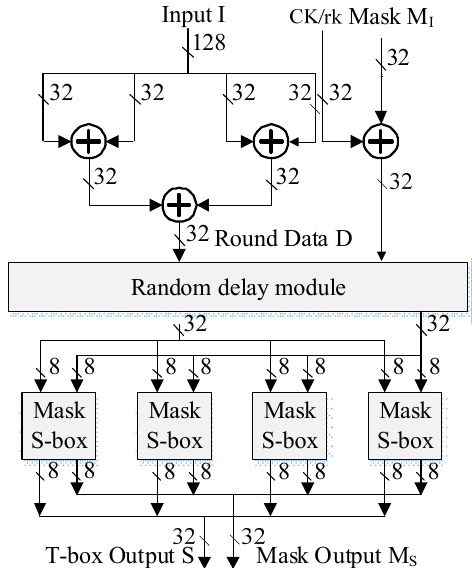
Figure 2. Mask T-box circuit structure diagram.